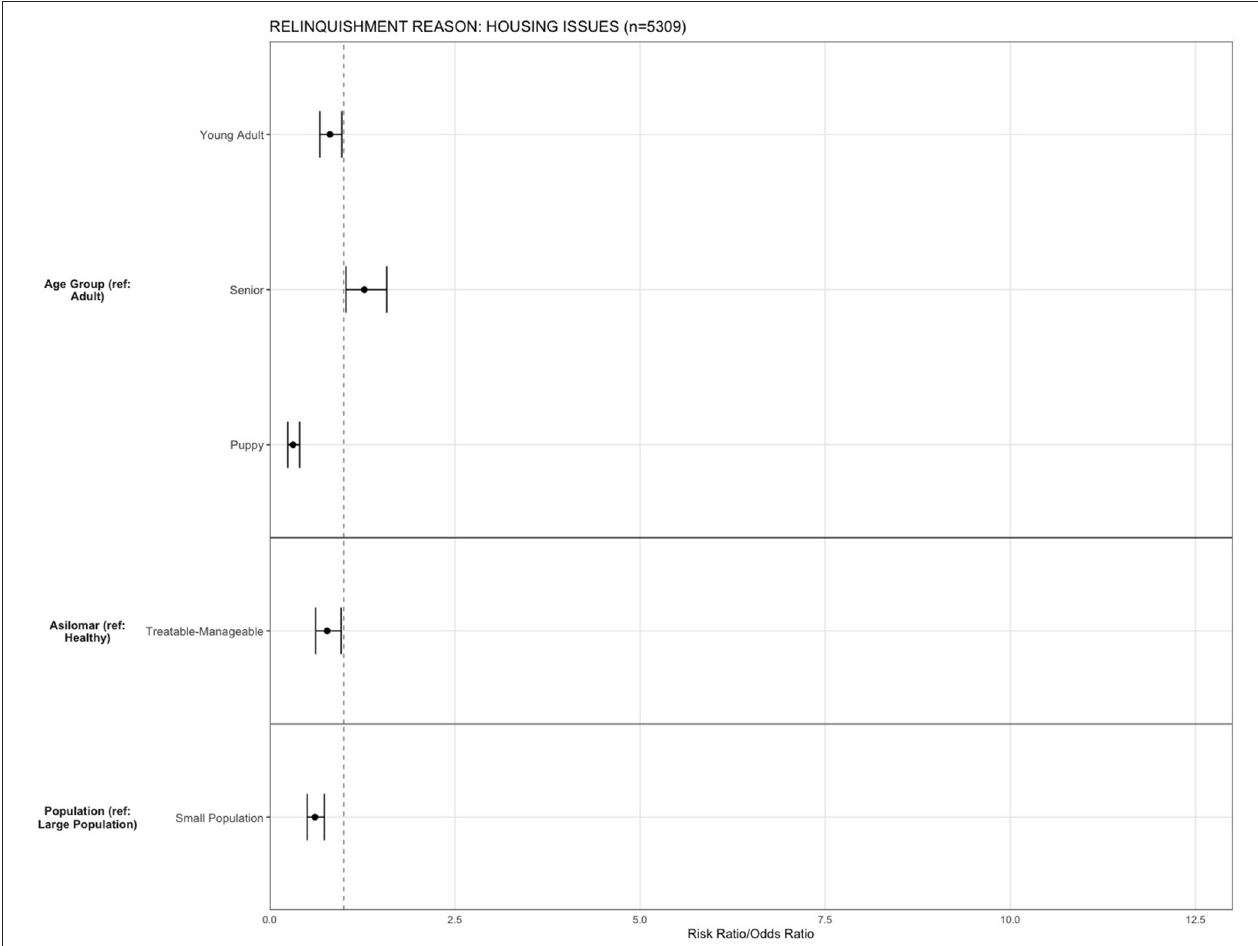
FIGURE 5 | The association between relinquishment reason and animal characteristics for puppies and dogs relinquished for the reason of “housing issues” ( n = 5,309). Characteristics include age group, Asilomar Accords category, breed type, dog size, sex, population center size, and year. The results of the logistic regression model are shown. Data are presented by risk ratios and their 95% confidence interval (bars); p < 0.05 when 95% confidence interval does not cross the vertical dotted line. A risk ratio > 1 suggests an increased risk of relinquishment of that the characteristic category, while a risk ratio < 1 suggests a reduced risk. Non-statistically significant results are excluded from the